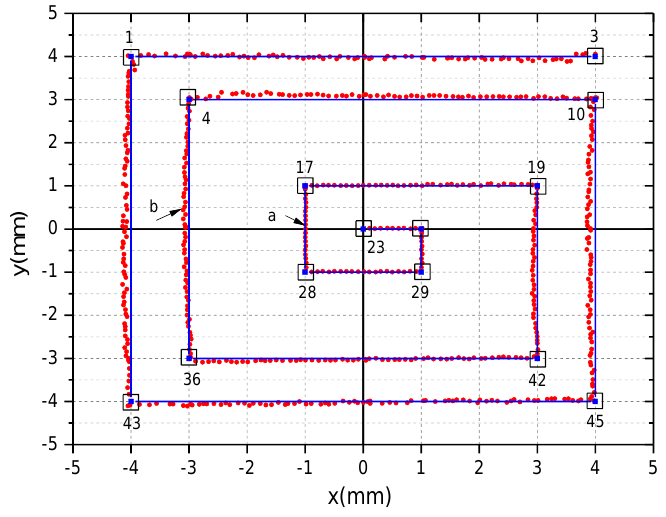
Figure 18. Position detection of solar spot based on SOF-FTIR.